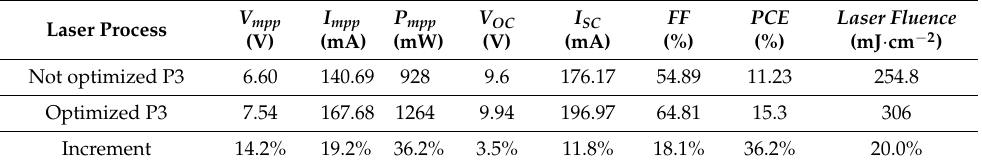
Table 1. Electrical parameters (extracted from 1 SUN I-V curves) for modules realized by employing non-optimized (first row) and optimized (second row) laser fluence value during P3 ablation step. The optimized removal of gold layer led to an increased module current and PCE , due to full electrical isolation of the module sub-cells from the counter electrode (CE)